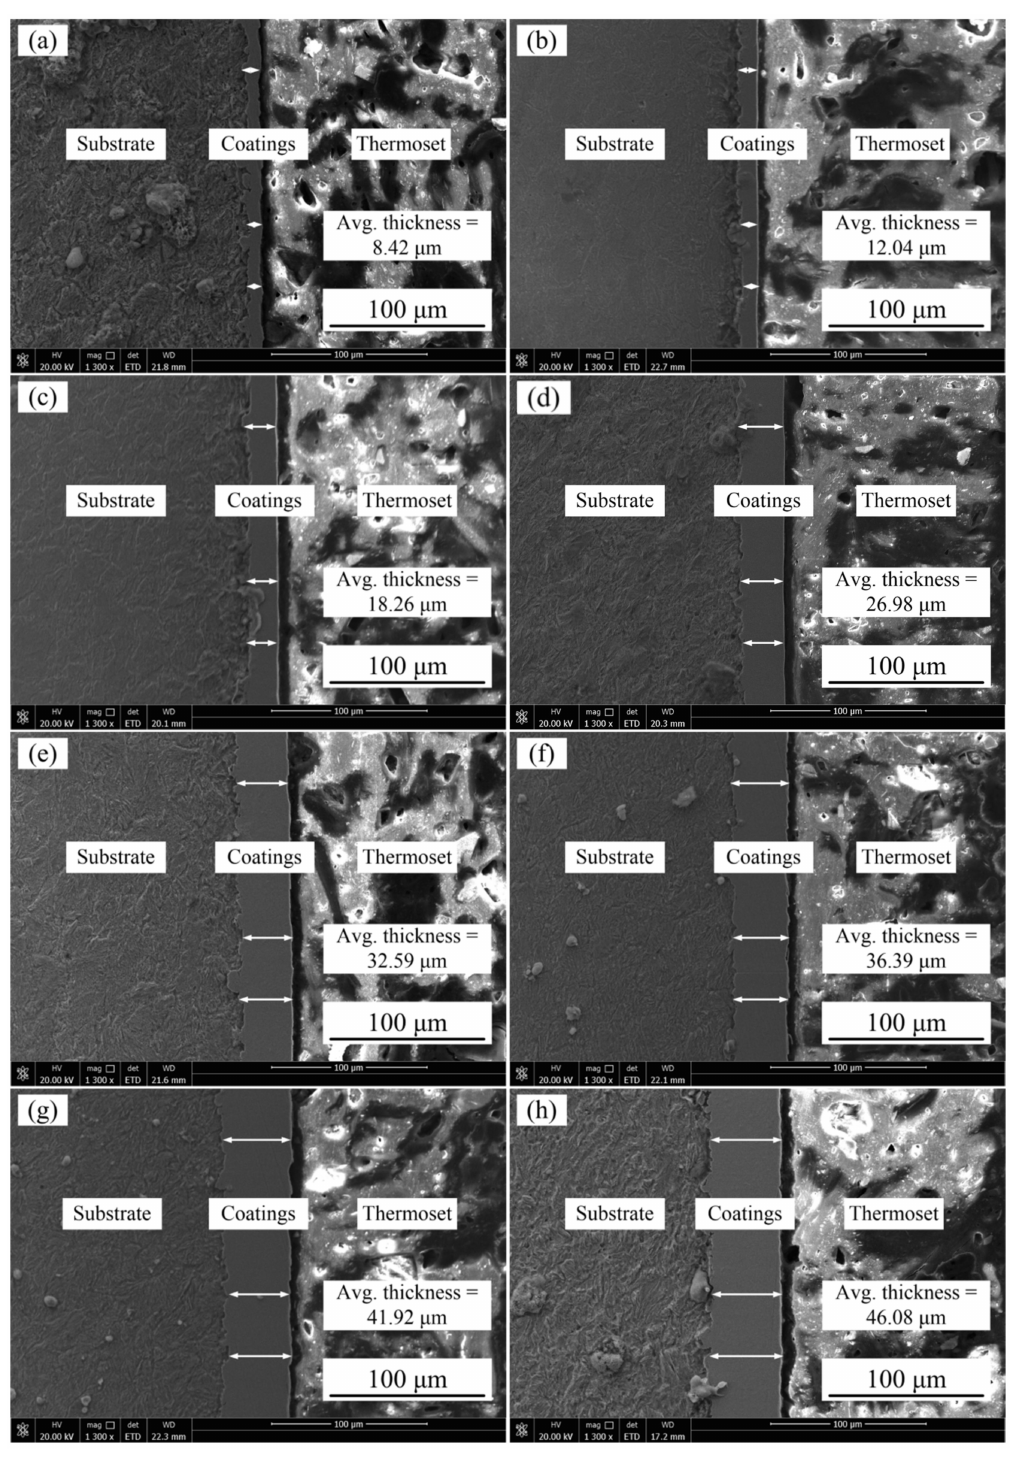
Figure 2. E ff ect of jet voltages on cross-section morphologies of Ni–Co–P alloy coatings: ( a ) 6 V; ( b ) 8 V; ( c ) 10 V, ( d ) 12 V; ( e ) 14 V; ( f ) 16 V; ( g ) 18 V; and ( h ) 20